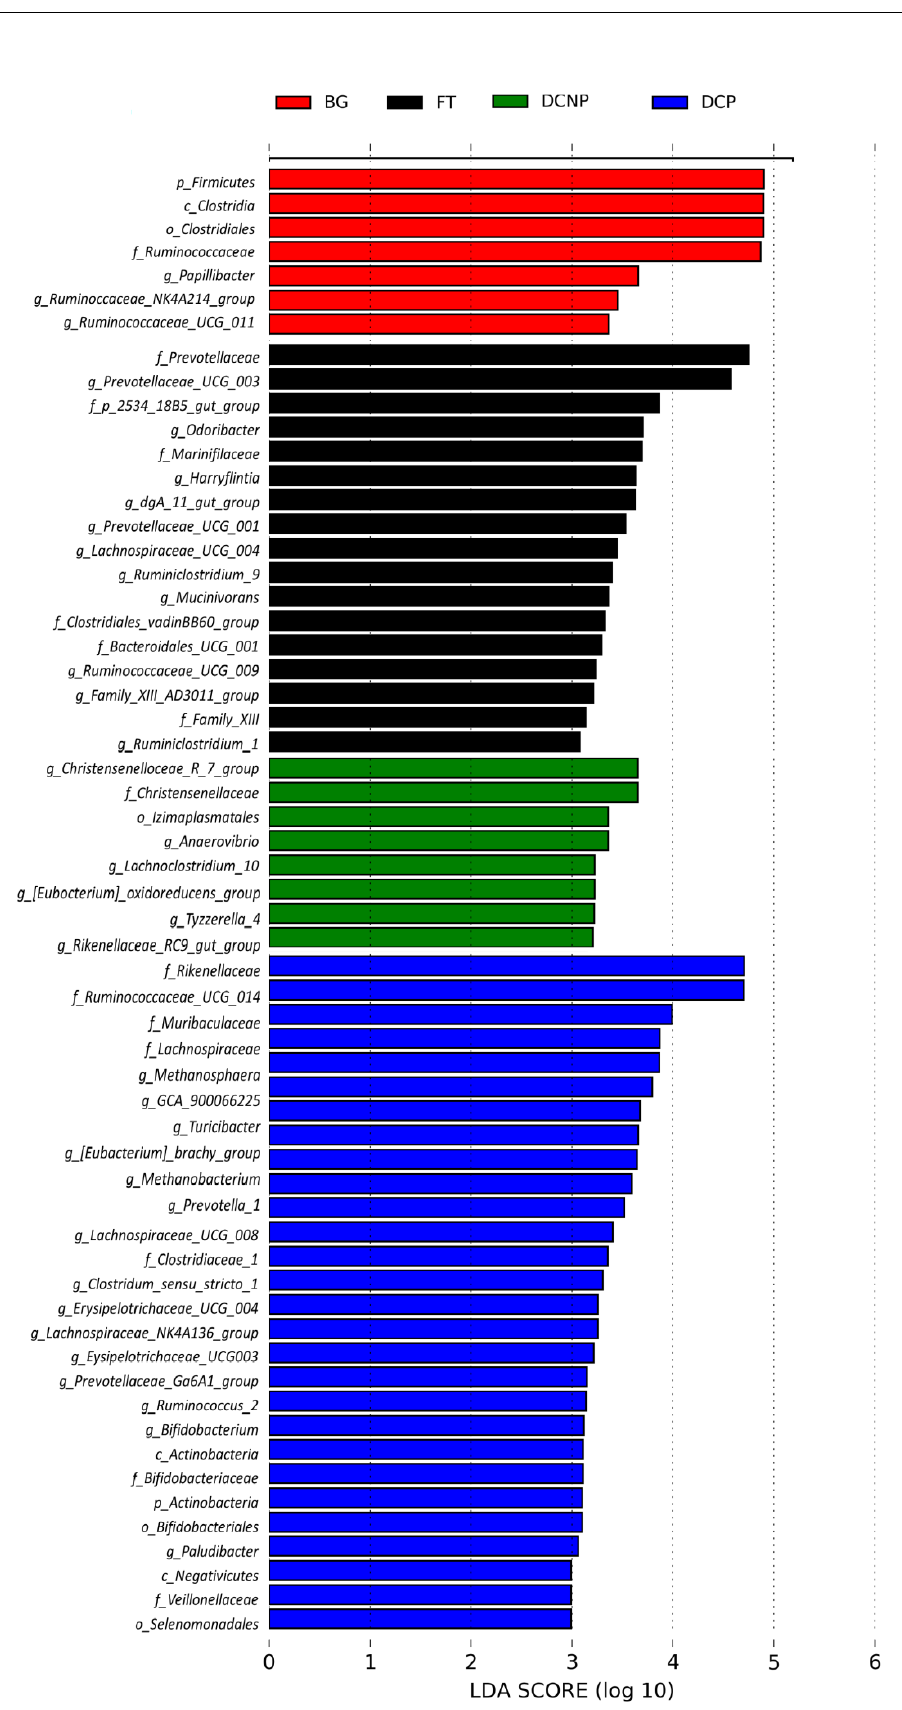
Figure 7. Histogram of the LDA scores for differentially abundant of fecal bacteria among the four groups